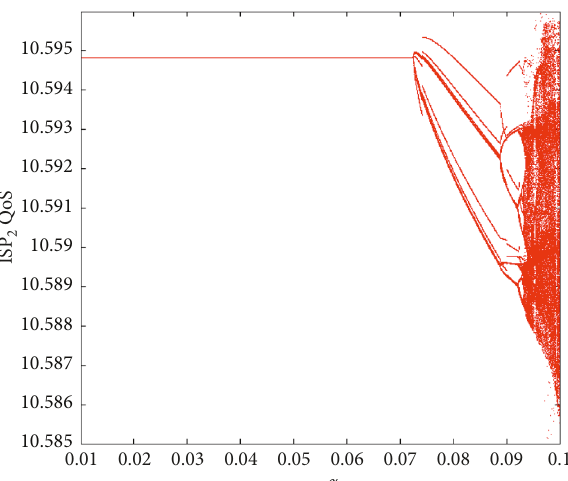
Figure 11: Bifurcation diagrams of p